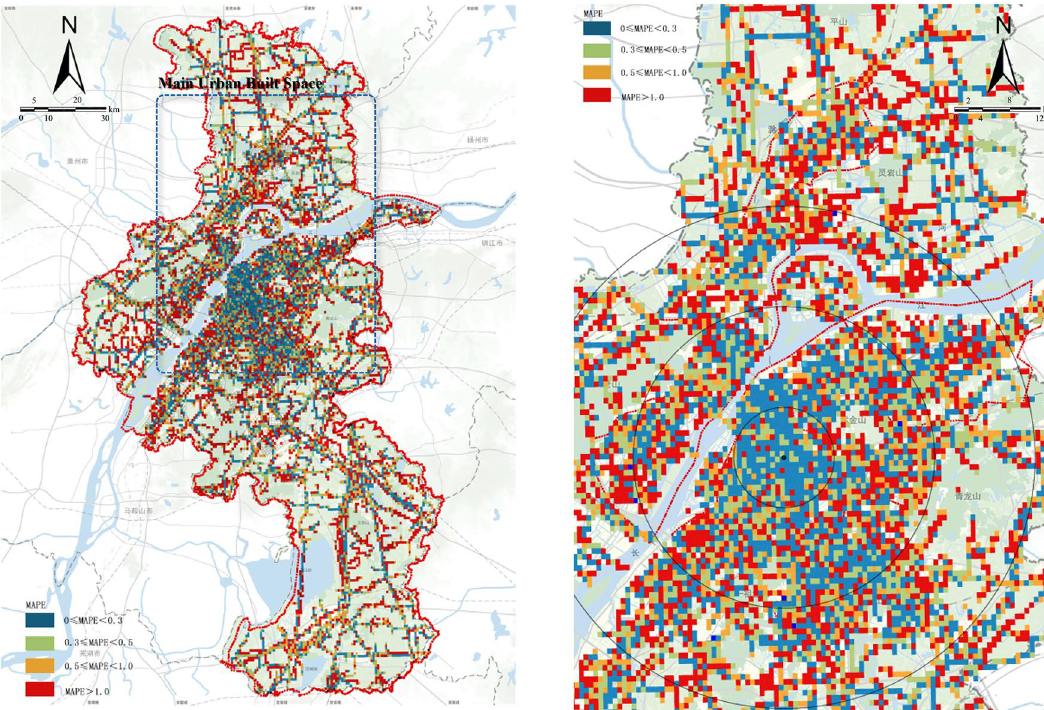
Figure 7. Spatial distribution of MAPE index (The left figure is MAPE is an overall urban space, while the right figure is MAPE is the main urban built space). Source Author made author made based on ESRI ArcGIS Pro Software (https:// pro. arcgis. com/ en/ pro- app/ latest/ get- start ed/ get- start ed.